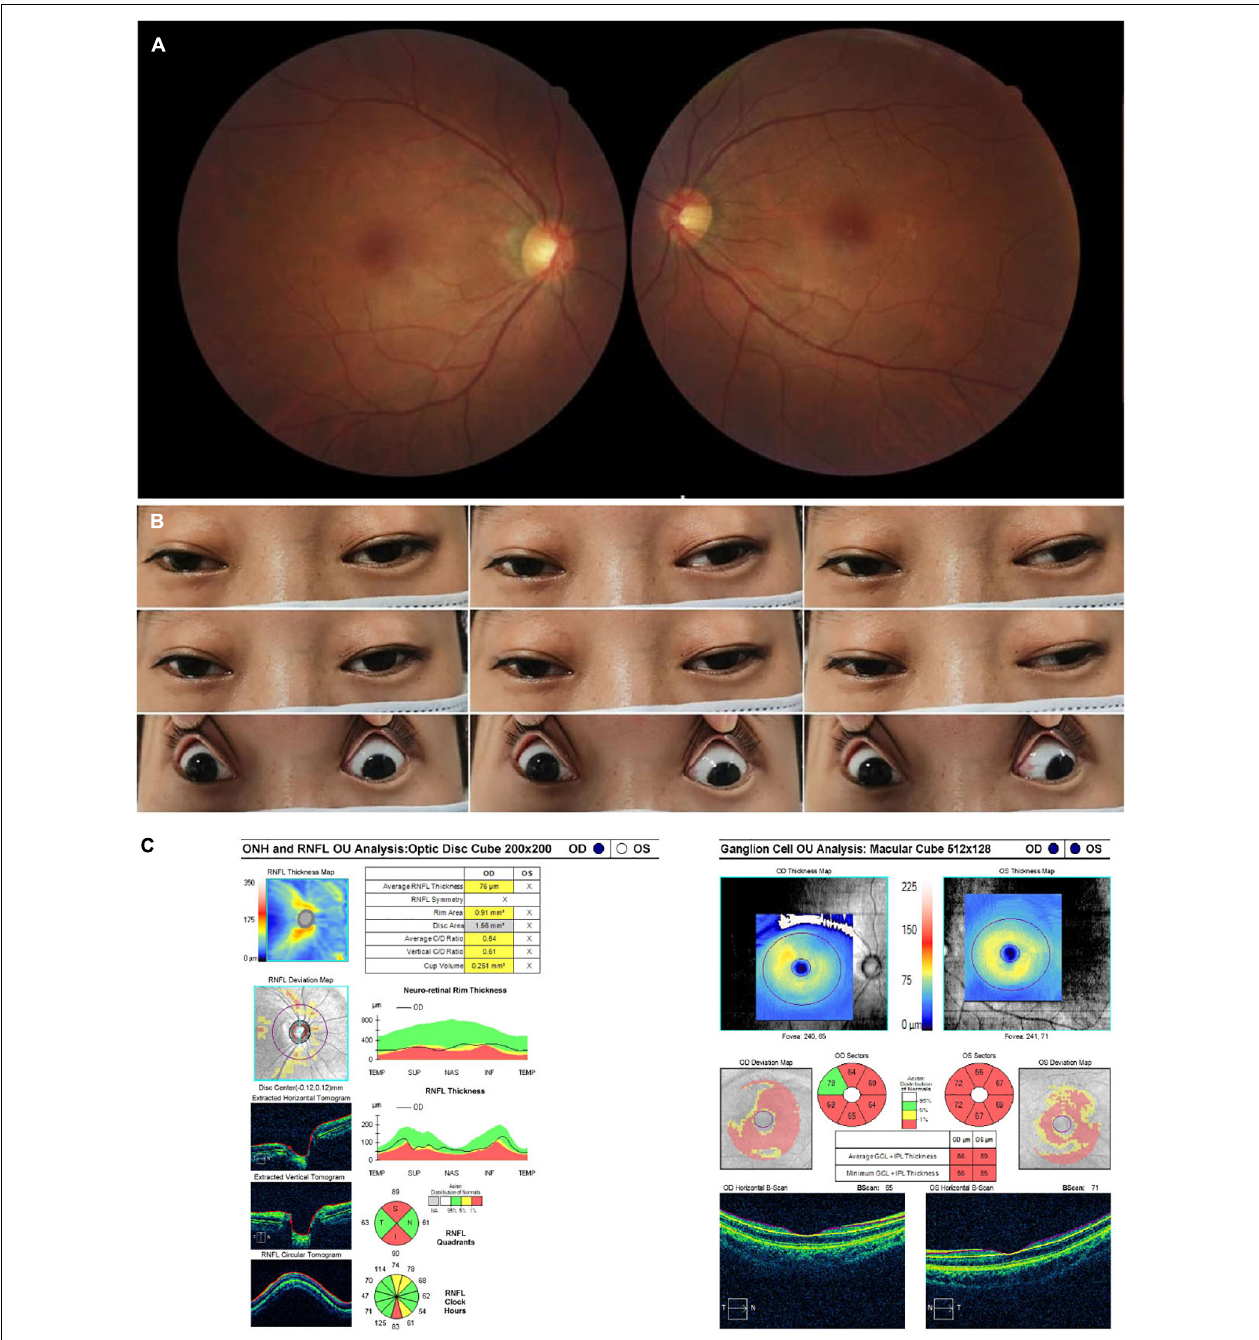
FIGURE 3 | Accessory examinations of case 3. (A) Fundus photos showed temporal pallor in the right eye. (B) Nine cardinal eye positions showed impaired mobility in both eyes, including adduction, abduction, elevation, and depression. (C) OCT showed thinning of RNFL superiorly and inferiorly in the right eye, with diffuse thinning of GCIPL bilaterally. The RNFL thickness of the left eye was not available due to poor cooperation.